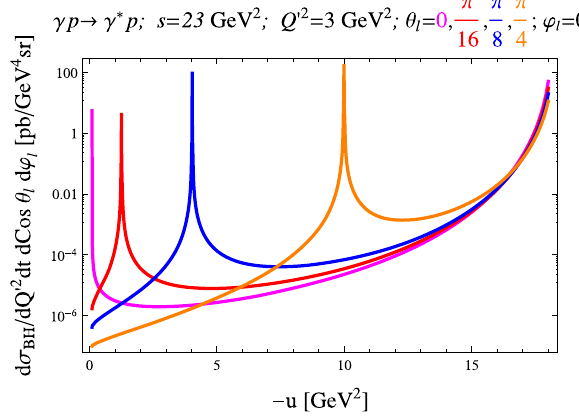
Fig. 6 The − u dependence of the Bethe–Heitler differential cross- section at ϕ (cid:6) = 0 and different values of θ (cid:6) (from left to the right: θ (cid:6) = 0 , π , π , π ), at Q (cid:4) 2 = 3 GeV 2 and s = 23 GeV 16 8 4